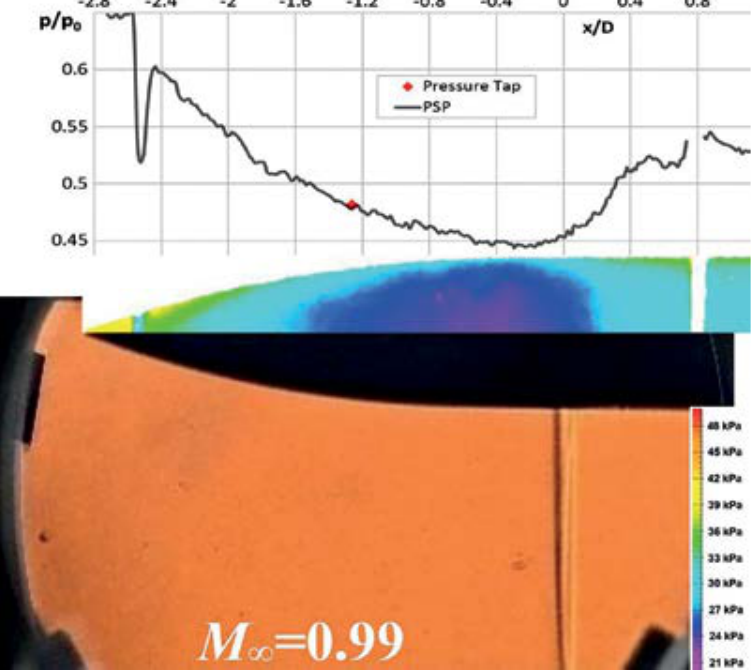
Figure 15. Comparison of results from PSP technique and Schlieren image for tangent–ogive model with a blockage area ratio of 0.78% for a stagnation pressure of 80 kPa and a stagnation temperature of about 300